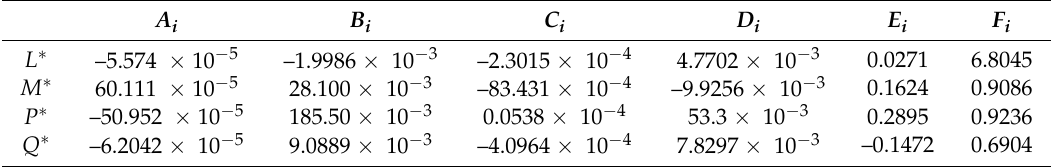
Table 1. The values of the coefficients of Equation